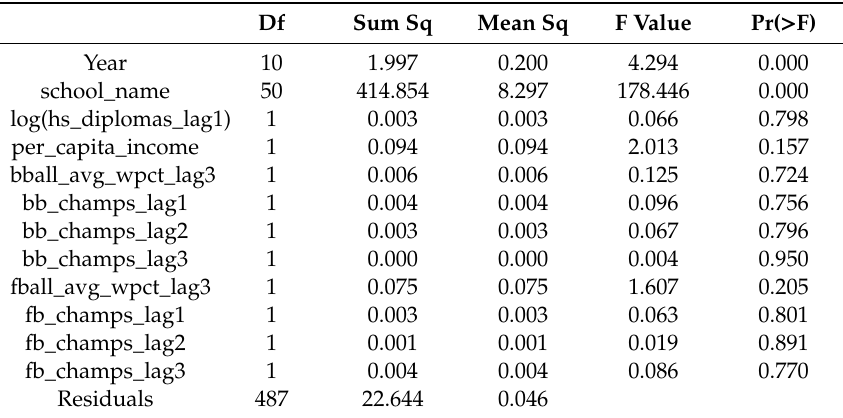
Table A6. ANOVA table for log(State).